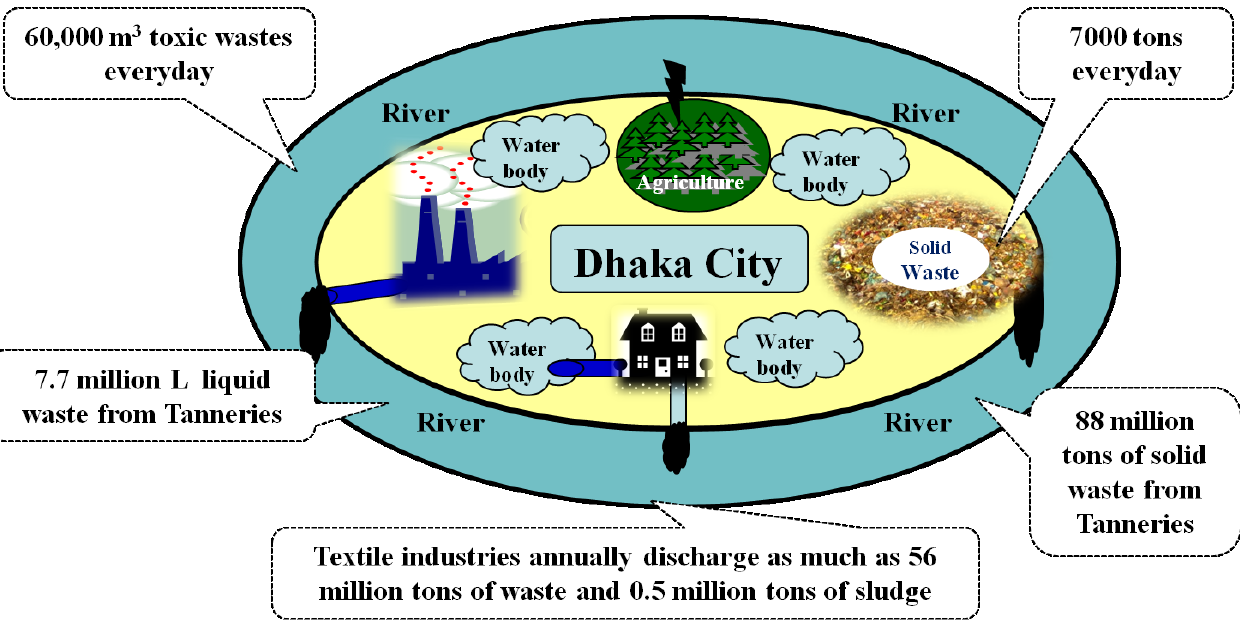
Figure 1. The schematic diagram of river pollution around Dhaka City from different pollution sources. The main sources include industrial untreated wastewater, tannery waste, municipal solid waste, household waste,